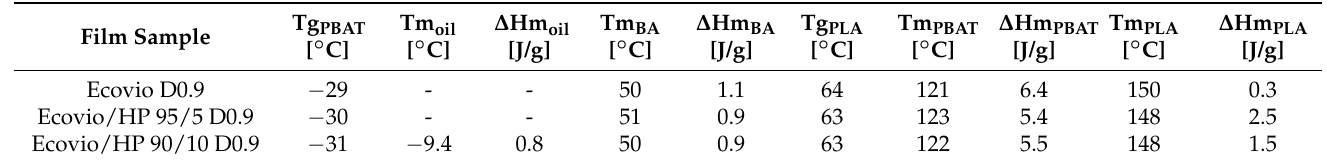
Table 6. DSC results of active films produced at different HP loadings (0, 5, 10 wt%) and draw-up speed equal to 0.9 m/min